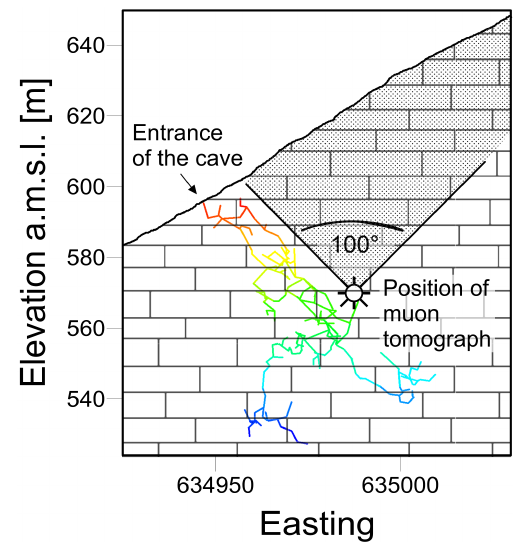
Fig. 6. The West-East cross section of the Aj´and´ek Cave (G. G. Barnaf¨oldi et al. , 2012). quency of 0 . 04 Hz.